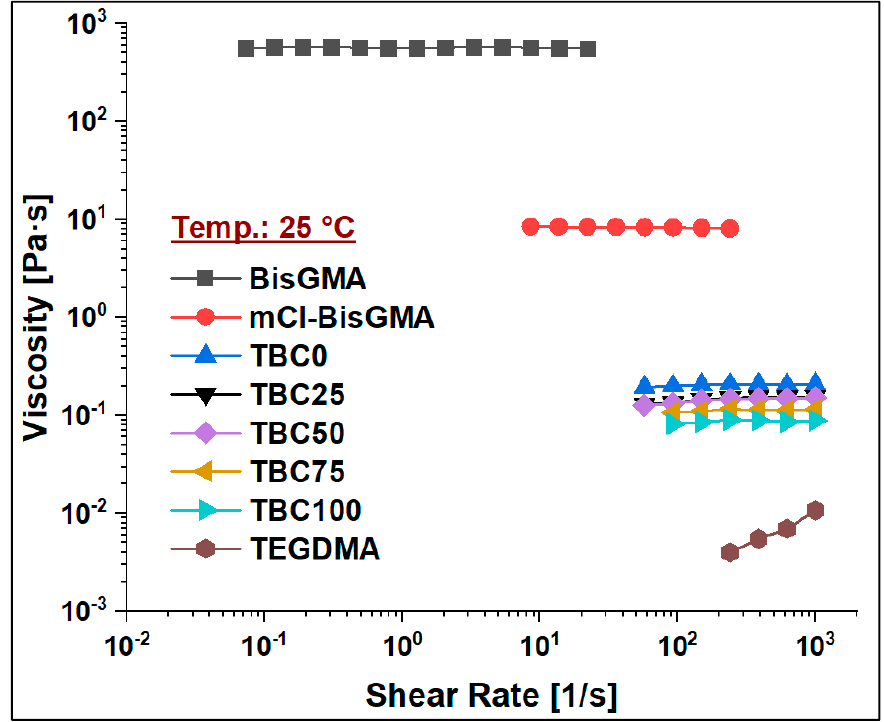
Figure 8. Viscosity curves of BisGMA, mCl-BisGMA, TEGDMA, and resin mixtures TBC0–TBC100 at 25 °C.